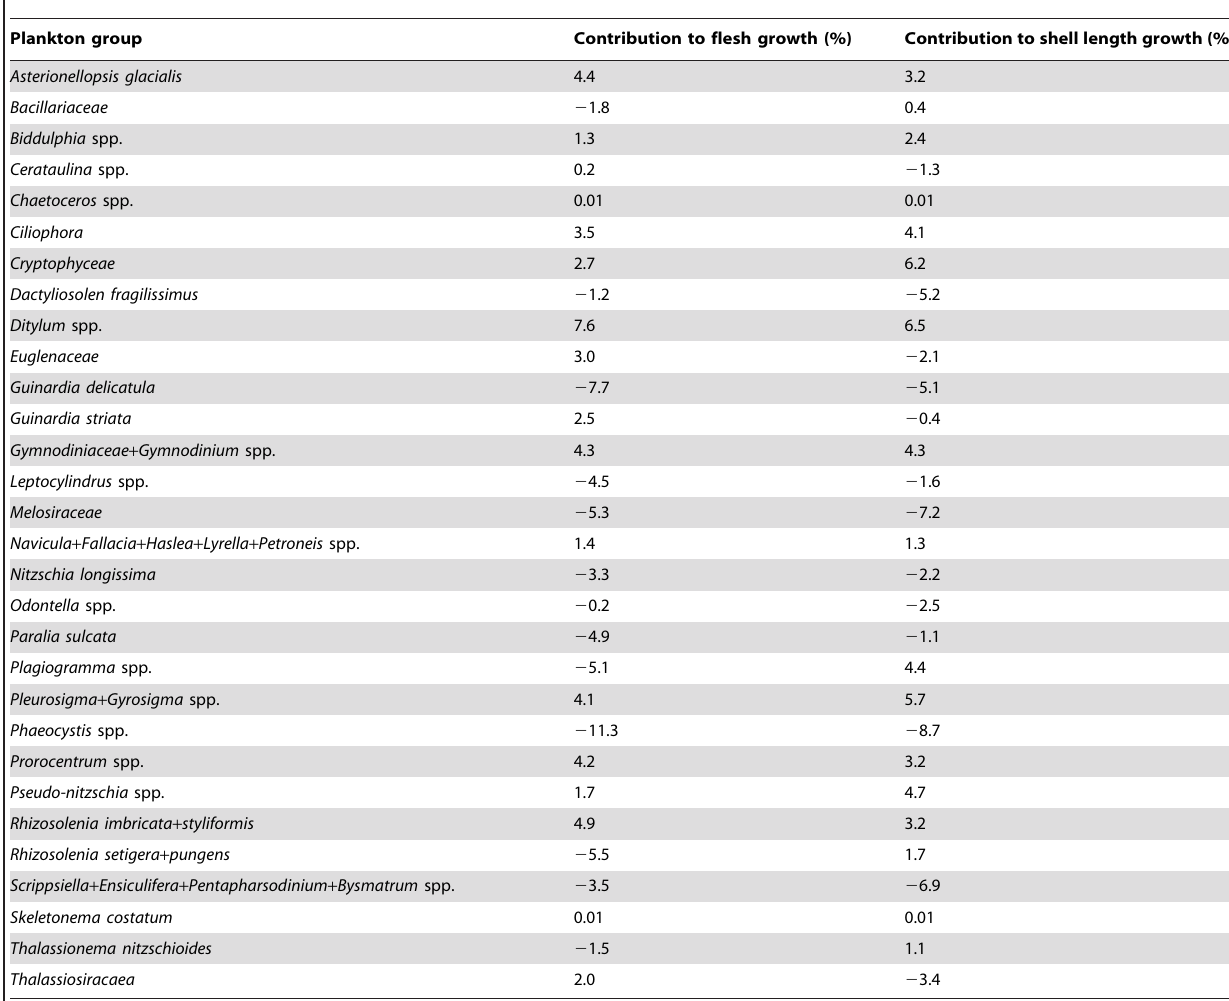
Table 3. Phytoplankton groups and contributions for flesh- and length-based growth.